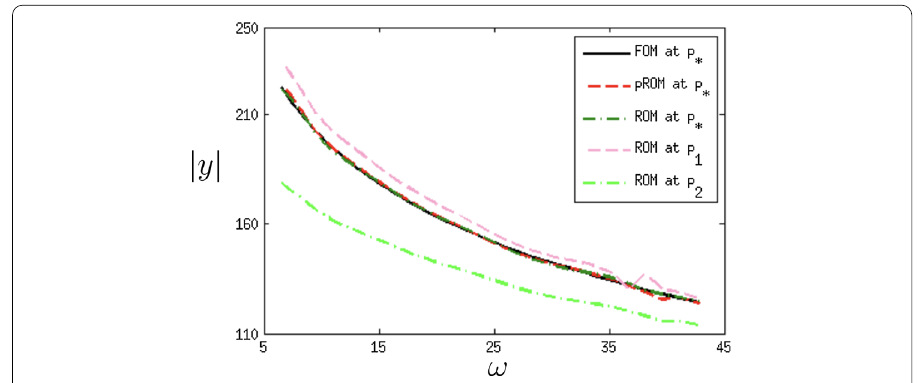
Fig. 4 Interpolation of Loewner ROMs in the original form. The pROM with order k = 21 is obtained by interpolating nonparametric Loewner ROMs in the original form at p 1 = 10 and p 2 = 268 . 3. The FRFs at p ∗ = 65 . 51 are shown for comparison